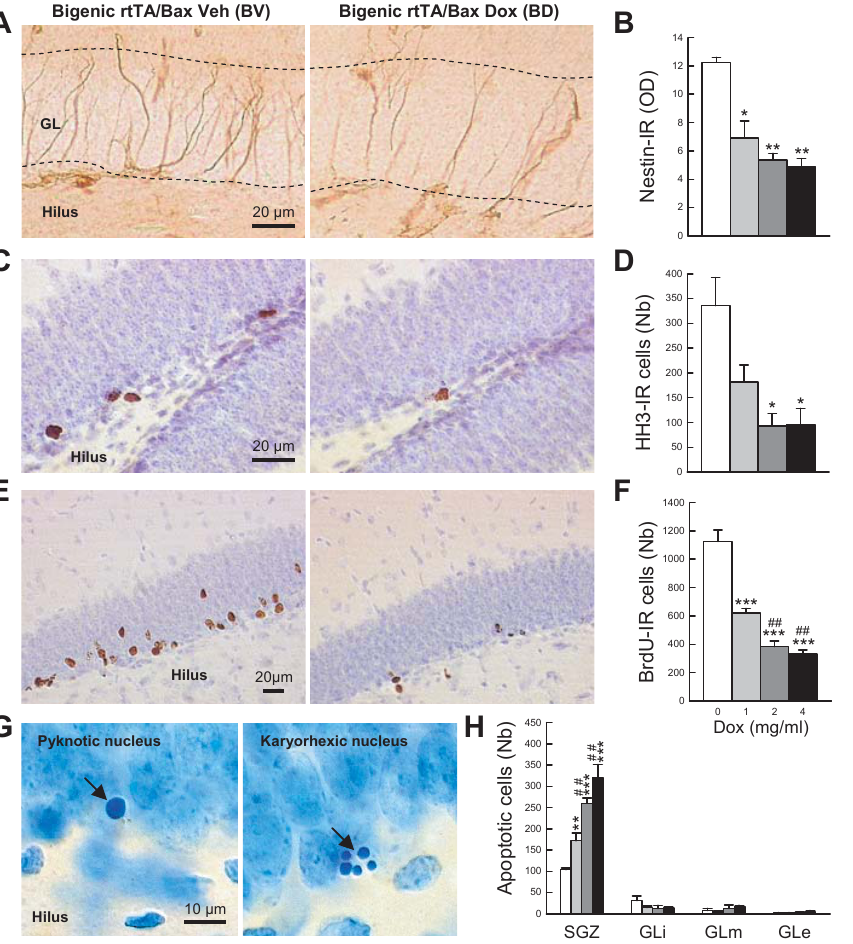
Figure 2. Effects of short-term Dox treatment on adult hippocampal neurogenesis. ( A ) Illustration of nestin staining. ( B ) Densitometric analysis of nestin-IR. ( C ) Illustration of dividing cells visualized by HH3 staining. ( D ) Number of HH3-IR cells. ( E ) Illustrations of newborn cells visualized by BrdU staining. ( F ) Number of BrdU-IR cells. ( G ) Illustrations of apoptotic cells. ( H ) Number of apoptotic cells in the subgranular zone where newborn cells are produced (SGZ) and in the internal (GLi), medial (GLm) and external (GLe) granular cell layer. GL=granular cell layer. *: p # 0.05, **: p # 0.01, ***: p # 0.001 in comparison to the bigenic-vehicle group. ## : p # 0.01, in comparison to bigenic fed with Dox at 1 mg/ml.